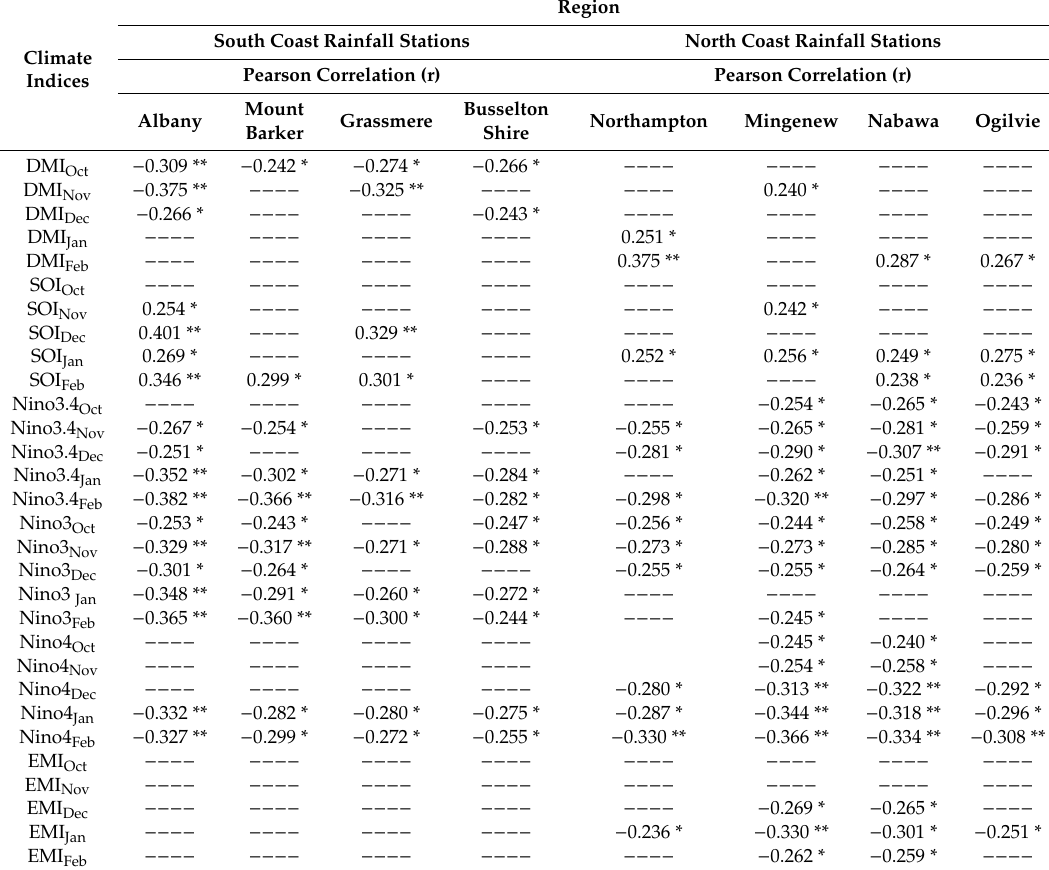
Table 2. Pearson correlation (r) between lagged climate indices and autumn rainfall.